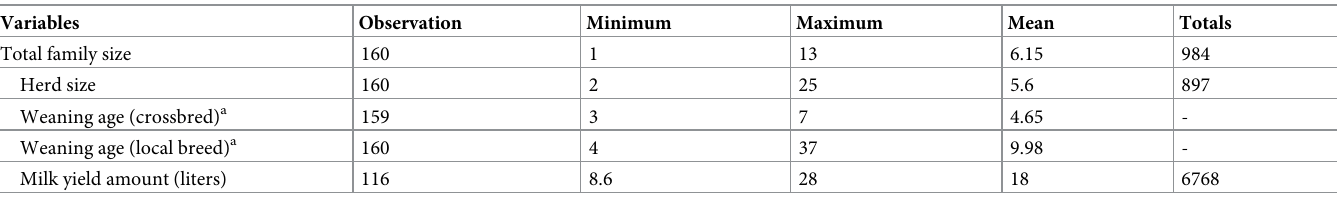
Table 1. Household and dairy performance characteristics.